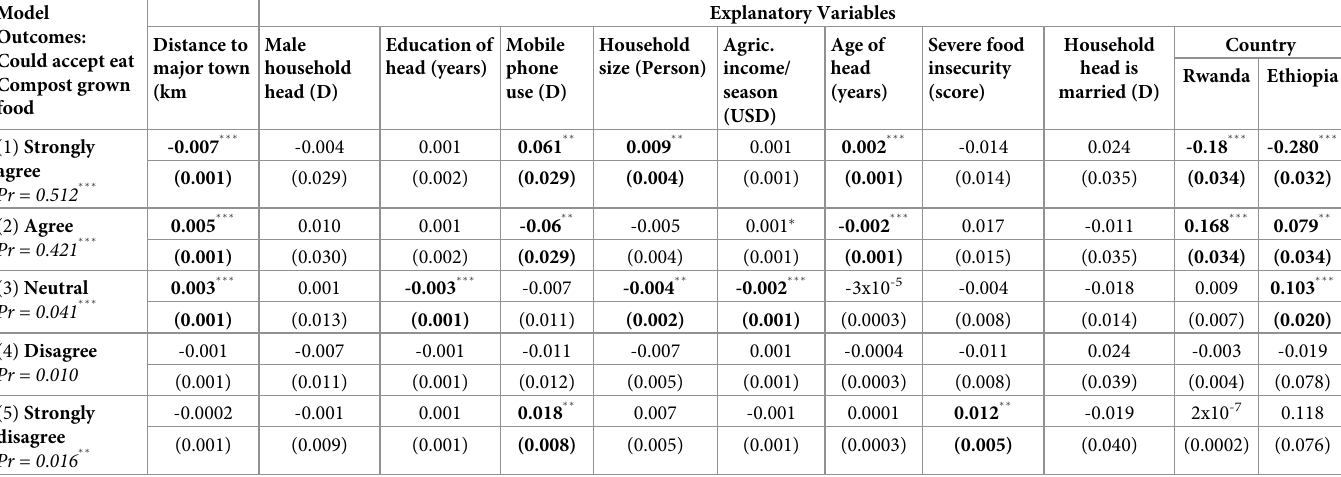
Table 8. Marginal effects after generalized ordered logit on eating foods grown on compost (from household, food, and agricultural residues like crop residues and manure). Model Outcomes: Could accept eat Compost grown